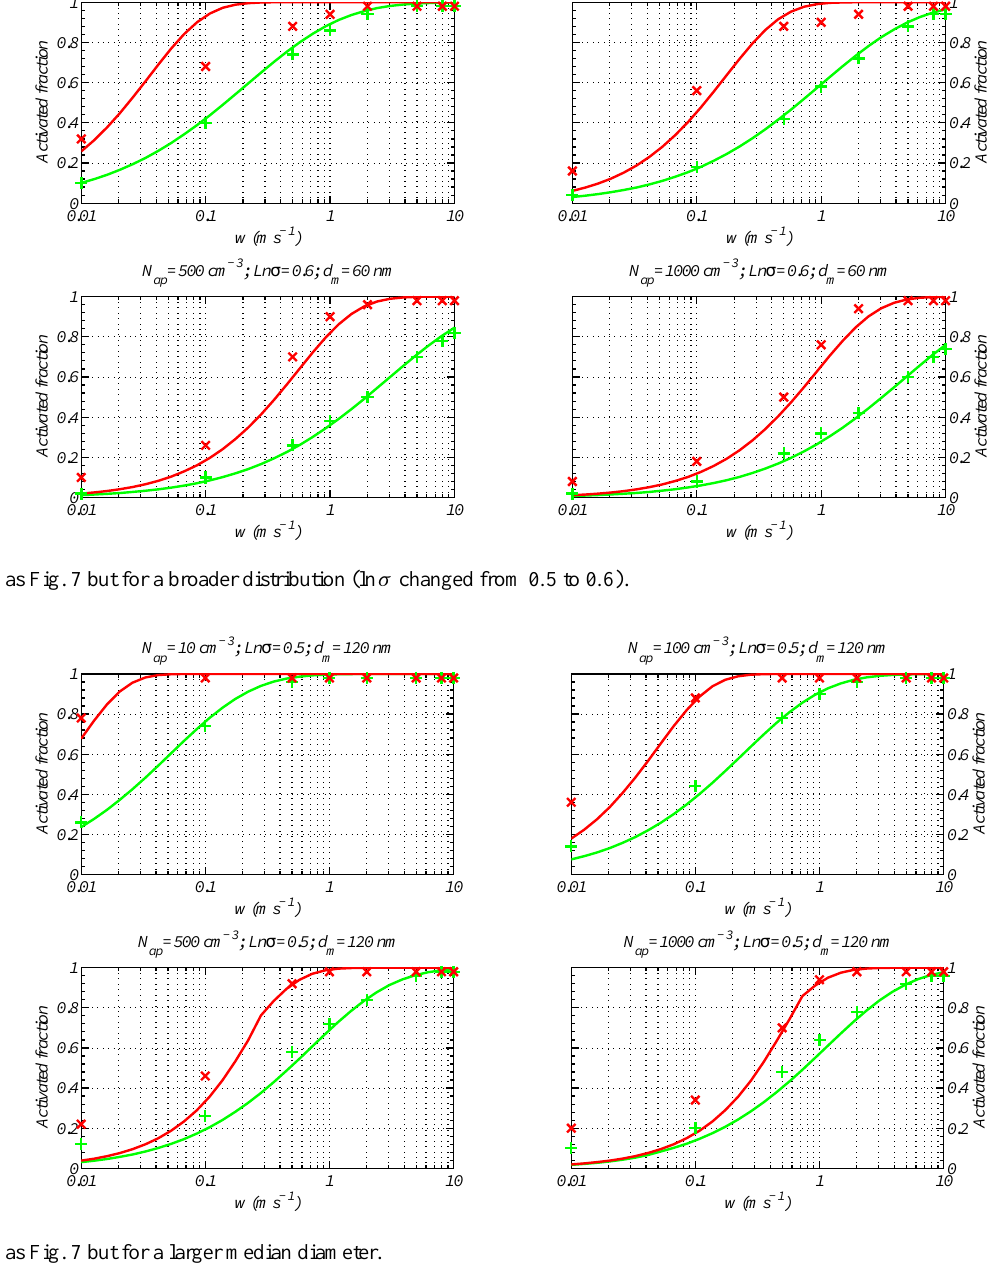
Fig. 9. Same as Figure 7 but for a larger median diameter. Fig. 9. Same as Fig. 7 but for a larger median